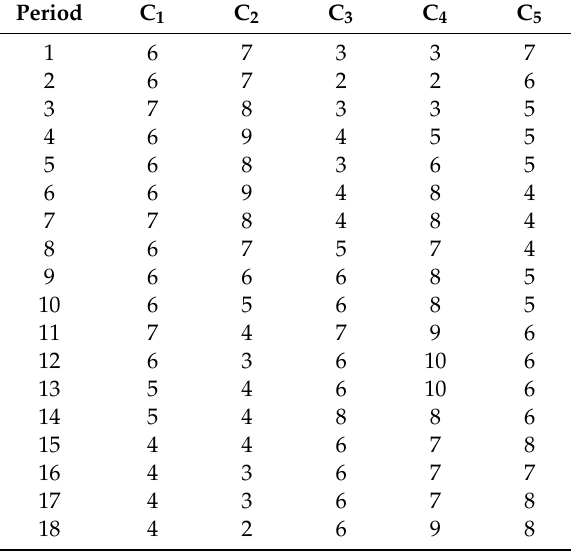
Table 2. Historical data of employee